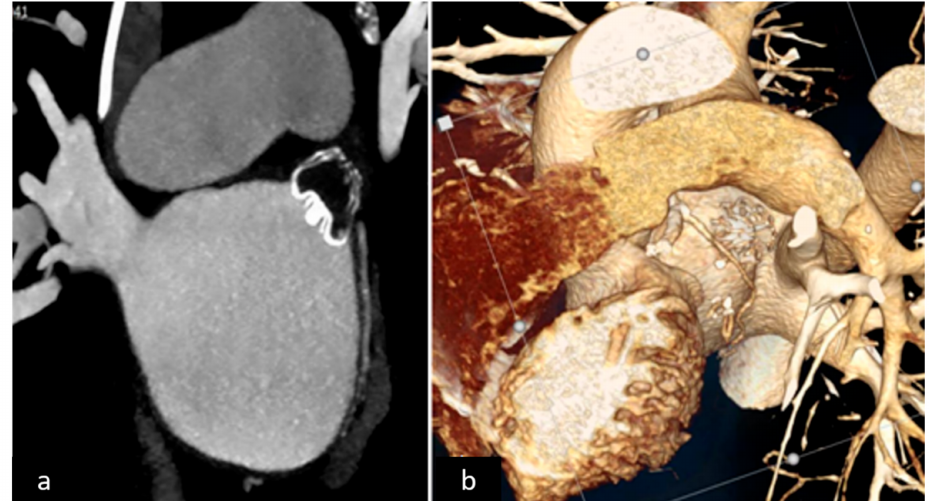
Figure 2. ( a ) 2D CT scan endocardial device, ( b ) 3D CT scan reconstruction.